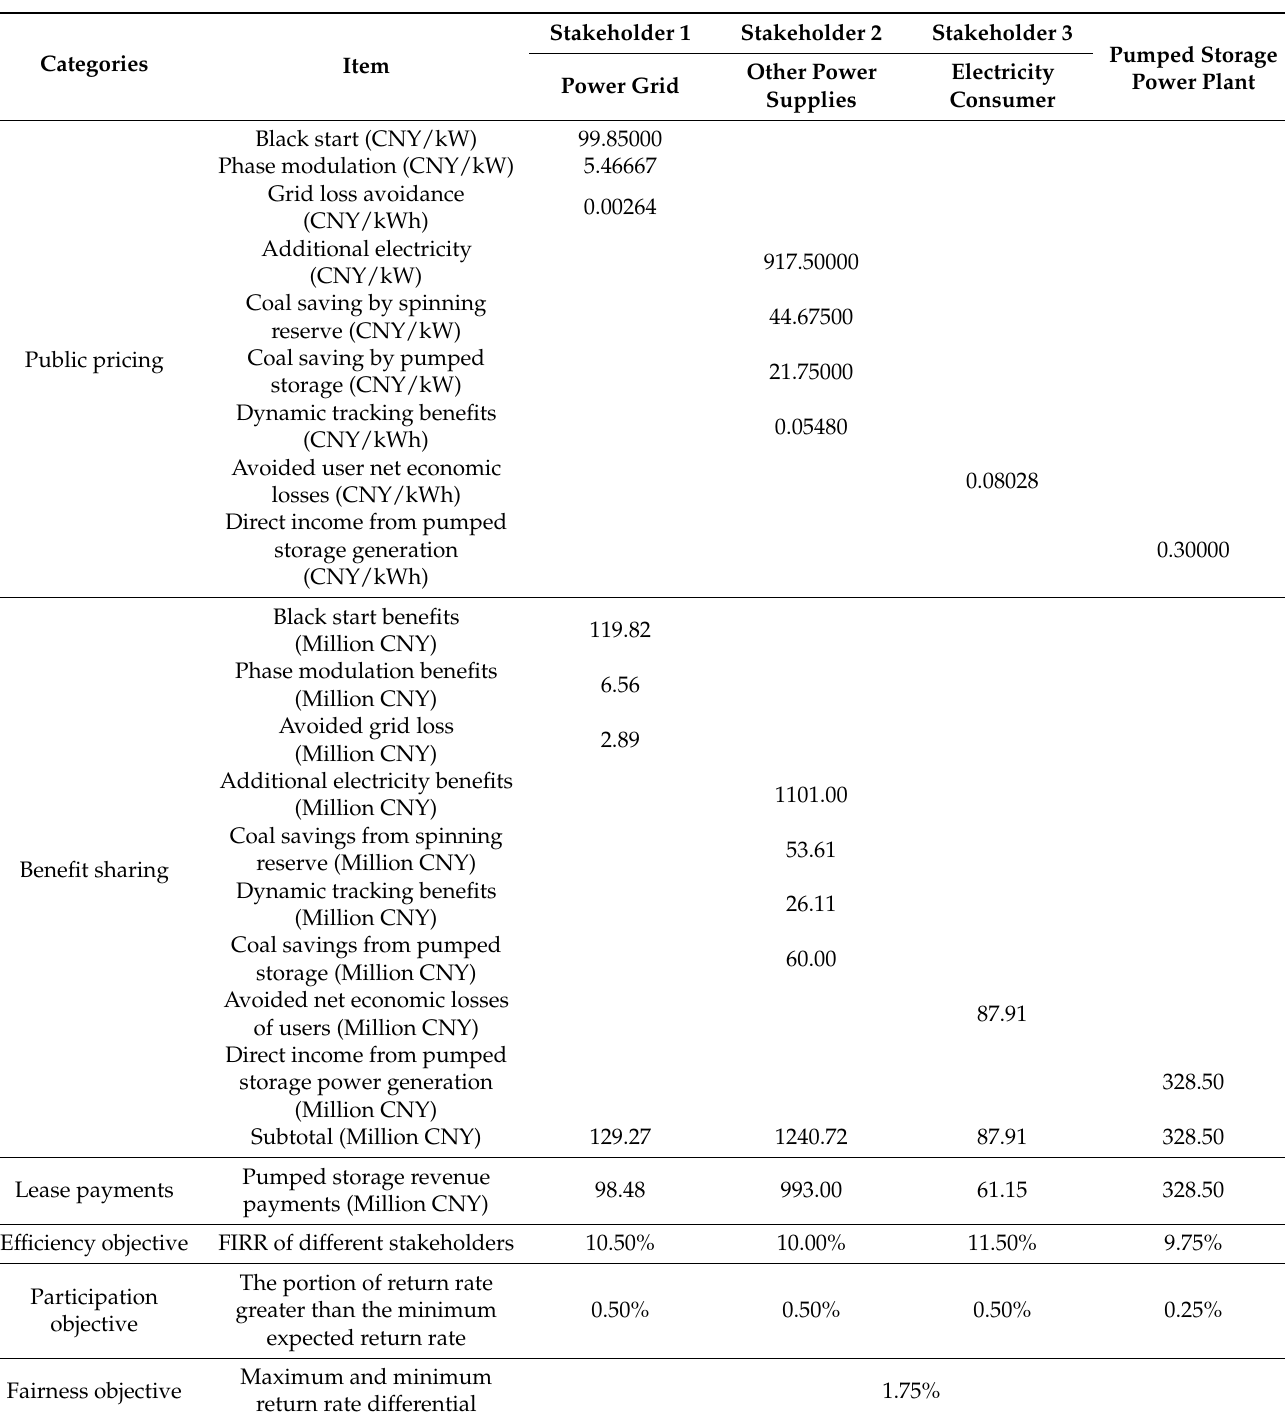
Table 1. Multi-dimensional means to realize the benefits of the BB pumped storage power plant and calculation results of multiple objective